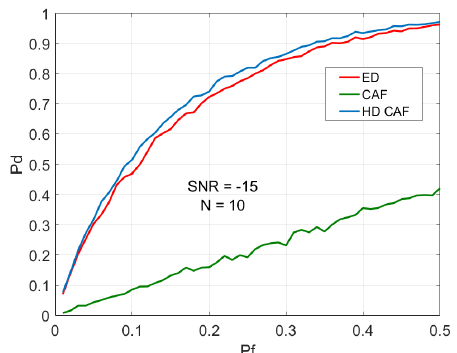
Figure 8. The ROC curves for HD CAV (without uncertainty of spectral density of noise power estimation influence)